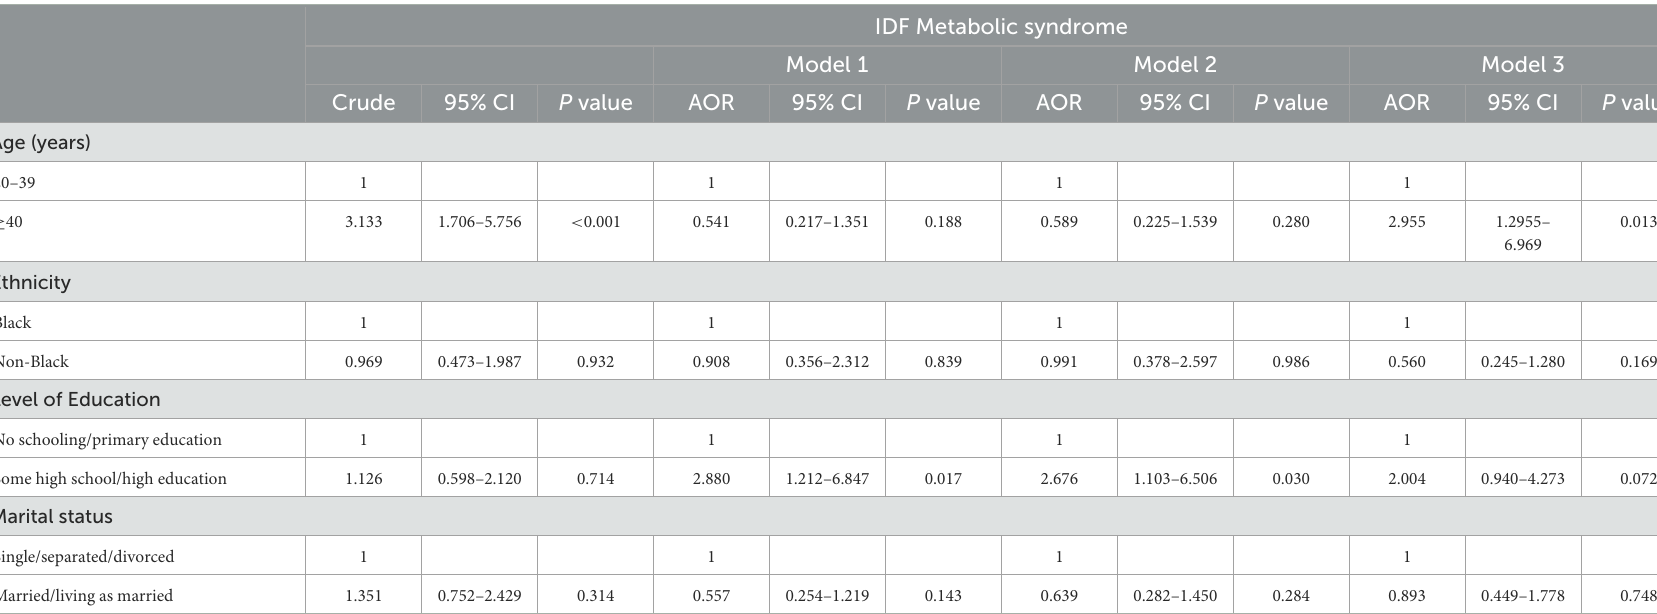
TABLE 2 A binary logistic regression analysis to show the association between the sociodemographic characteristics and the MetS status of South African minibus taxi